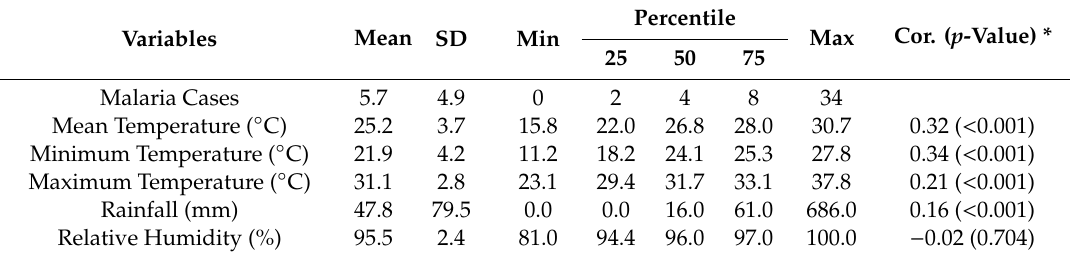
Table 1. DescriptivesummariesofweeklymalariacasesandmeteorologicalfactorsinRajasthali,2000–2009.